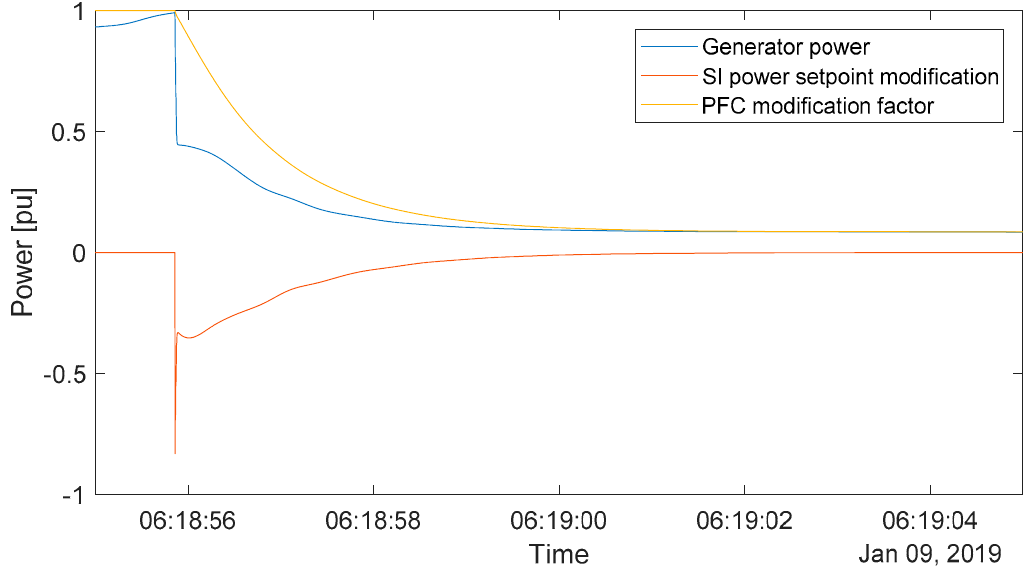
Figure 12. Results for scenario II. Generator power and the two frequency support functions: SI and PFC. Table 4. Results of scenario II. Maximum speed and duration in overspeed for all simulated